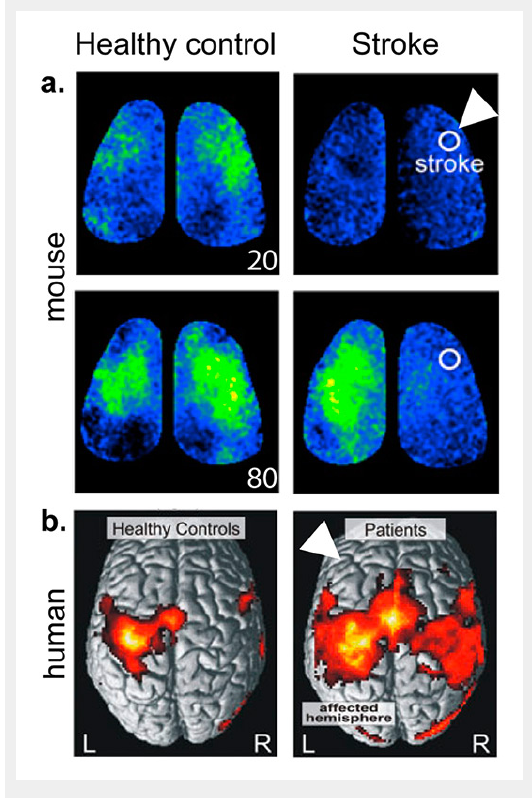
Comparison of neuronal connectivity after stroke in mouse and human. a. In-vivo imaging of mouse cortex during left forelimb stimulation shows sensory-evoked polarisation in control mice emerging immediately (20 ms) in a confined area representing left forelimb function. In contrast, forelimb stimulation after stroke resulted in a more diffuse signal encompassing mainly the contralateral hemisphere. Additionally, there is a significant shift in timing of signal propagation, with a delayed and prolonged response after stroke (compare signal maps at 20 and 80 ms after forelimb stimulation). b. Connectivity analysis based on significantly activated voxels (BOLD signal, fMRI) during movement of the right hand shows a distinct single-hemispheric cortical pattern in healthy controls. Hand movement in stroke patients were associated with enhanced and more extended neural activity in both hemispheres. White arrowheads mark the affected hemispheres.( Adapted from Mohajerani et al. 2011 [45] and Grefkes et al. 2008 [43], with